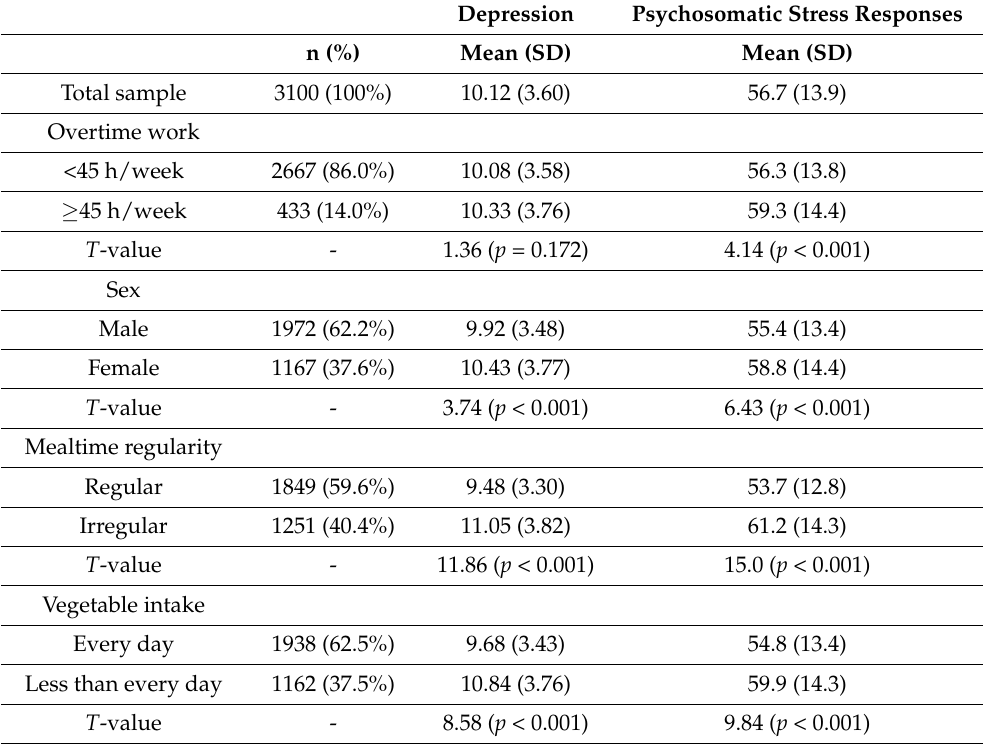
Table 1. Demographics of the respondents.